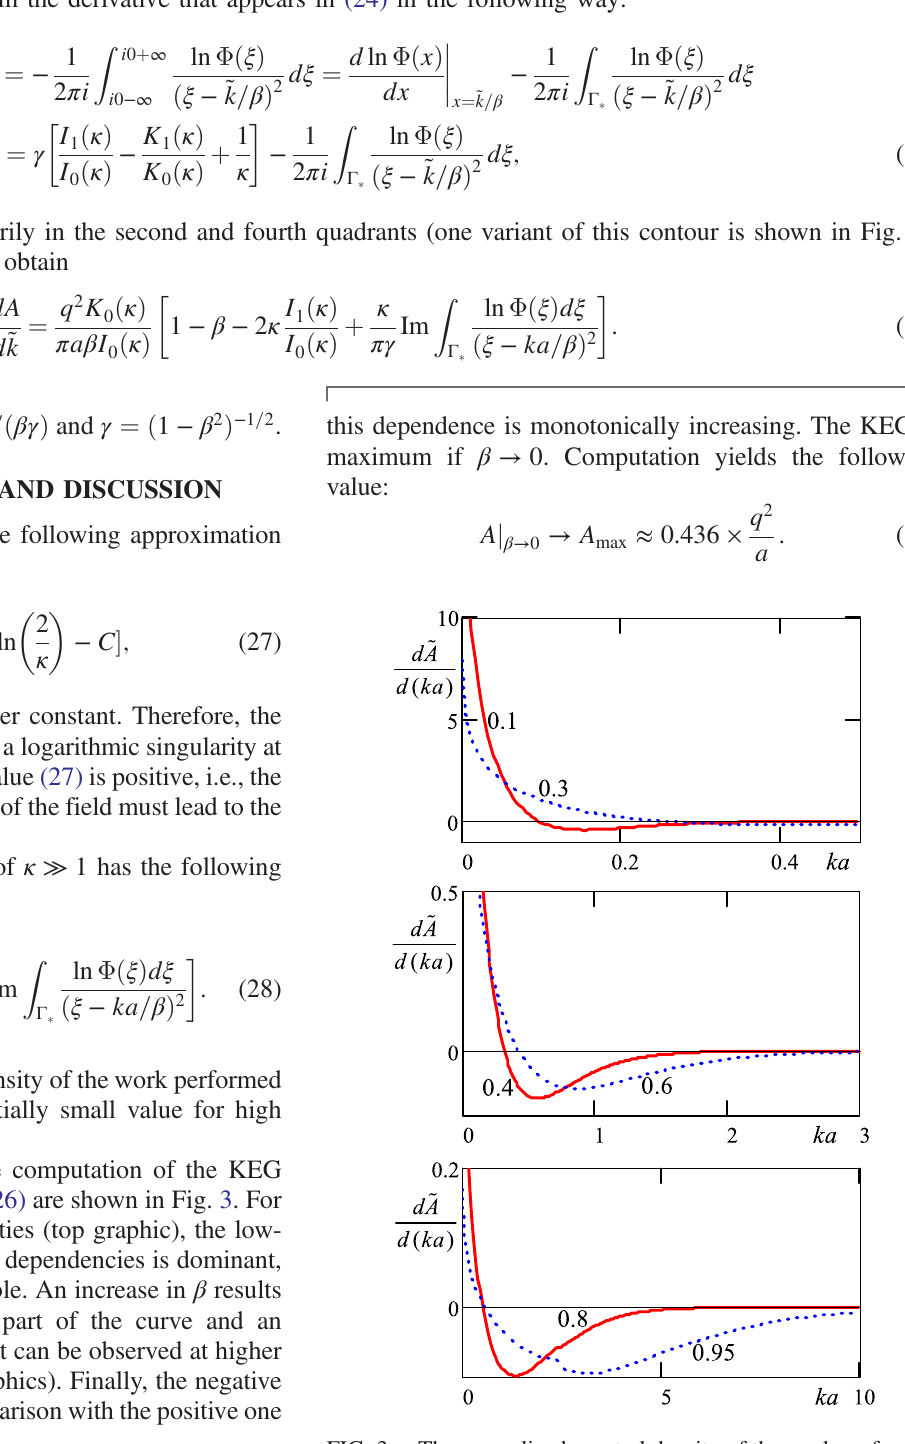
FIG. 3. The normalized spectral density of the work performed ~ A=d ~ A=d by the field, d ð ka Þ ¼ q − 2 ad ð ka Þ , depending on ka ¼ ω a=c for the different values of β that are indicated near the curves.